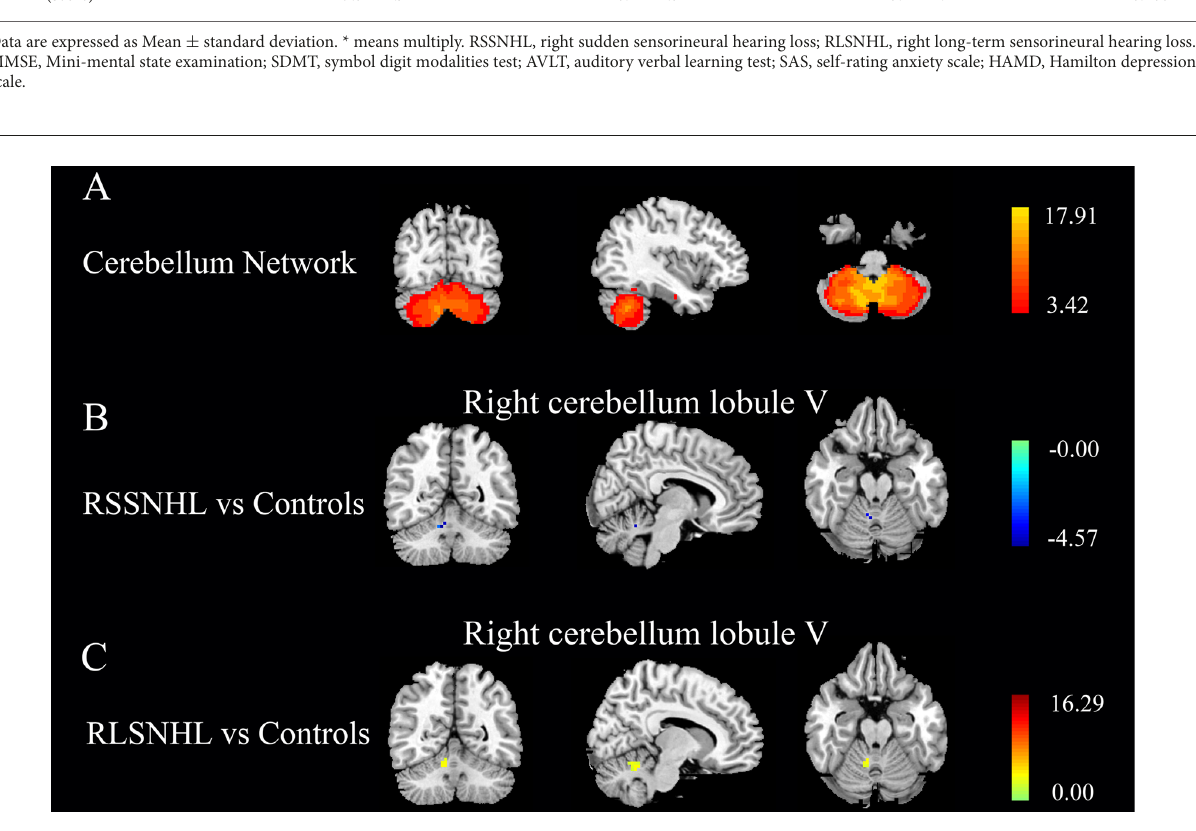
FIGURE1 Independent components analysis among RSSNHL, RLSNHL, and Controls. (A) Spatial maps of identified cerebellar network. (B) Difference of cerebellar network between RSSNHL and Controls. (C) Difference of cerebellar network between RLSNHL and Controls. The significant p was set at < 0.05 with family-wise error correction. RSSNHL, right sudden sensorineural hearing loss; RLSNHL, right long-term sensorineural hearing